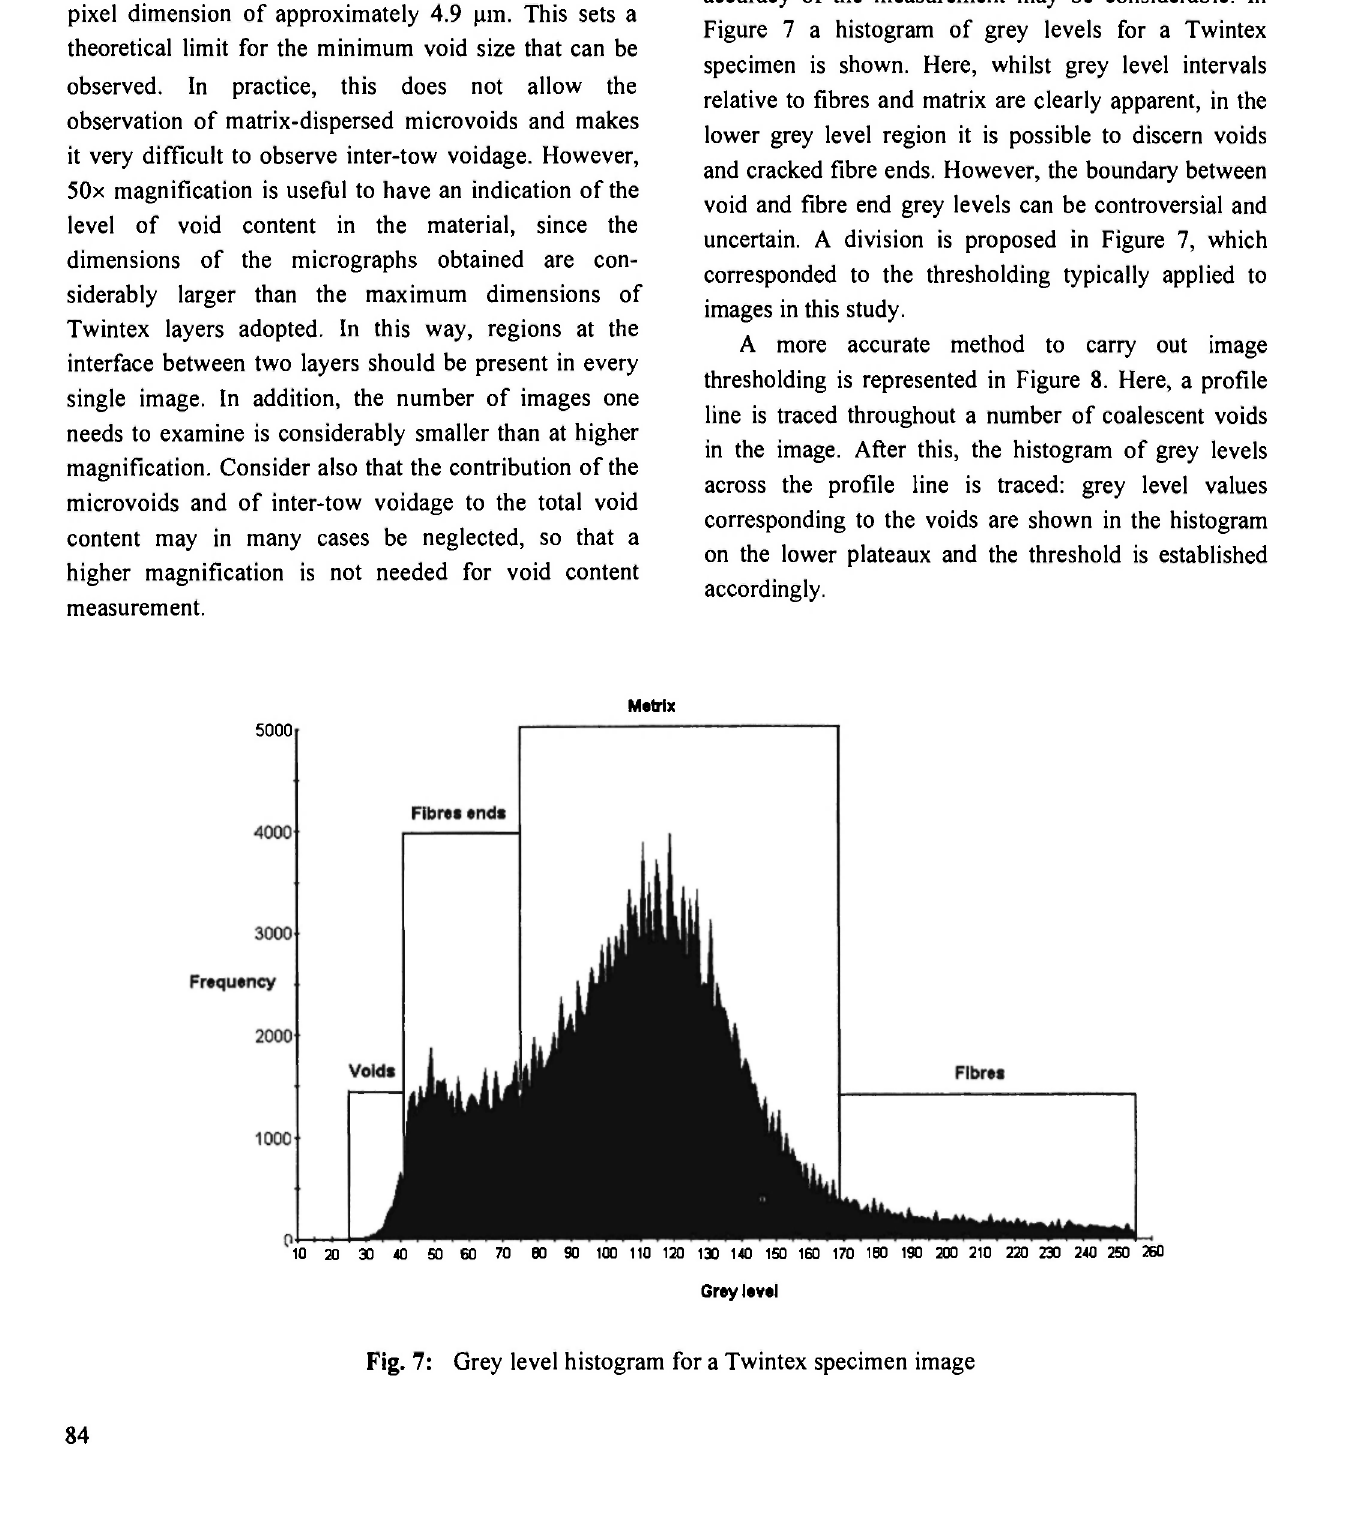
Fig. 7: Grey level histogram for a Twintex specimen